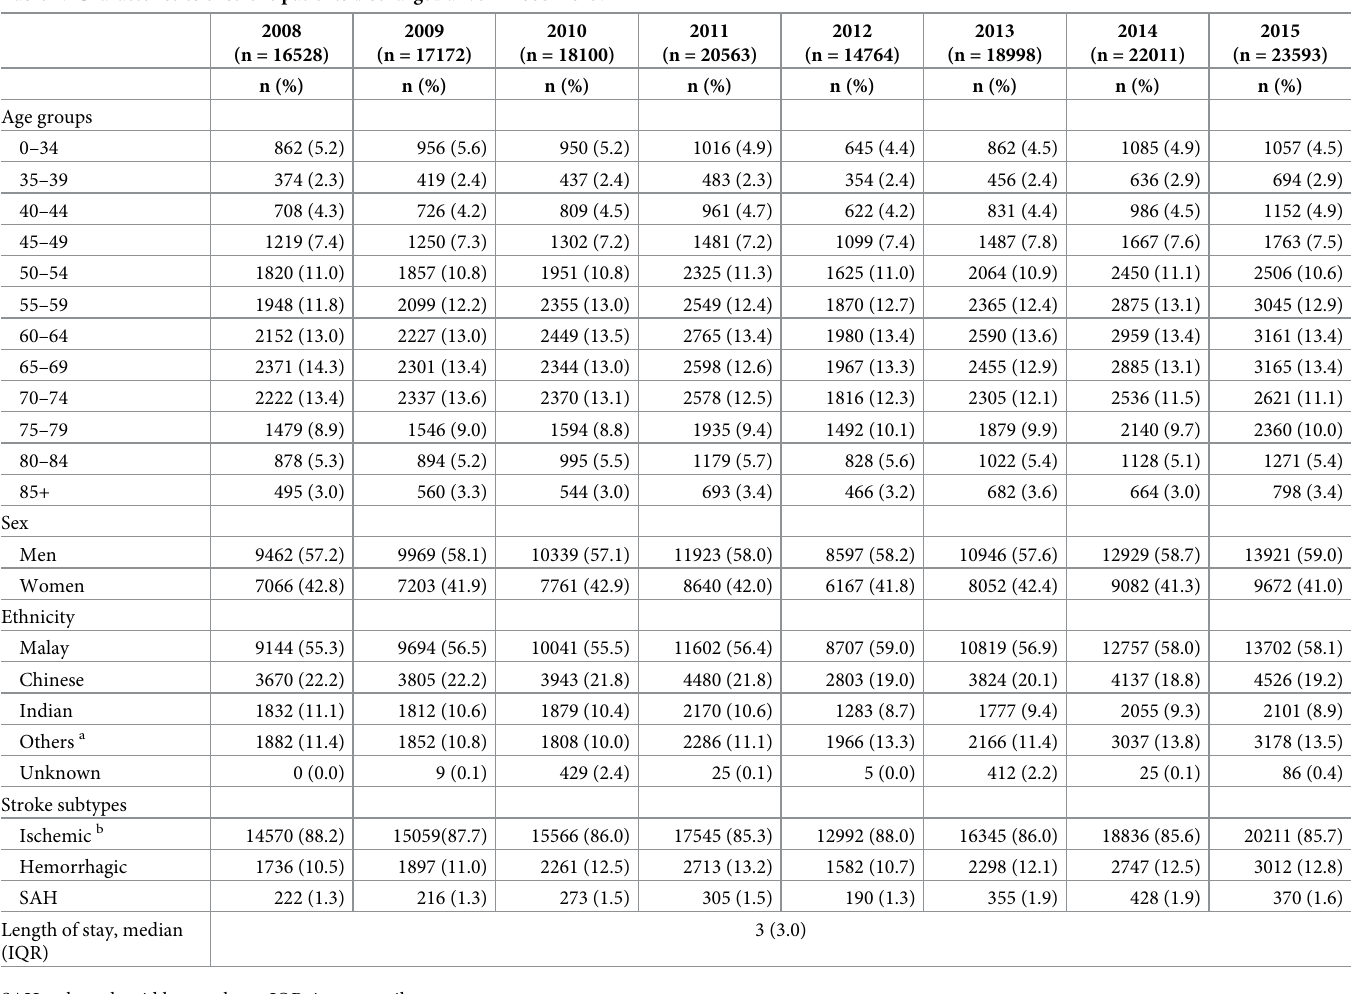
Table 1. Characteristics of stroke patients discharged alive in